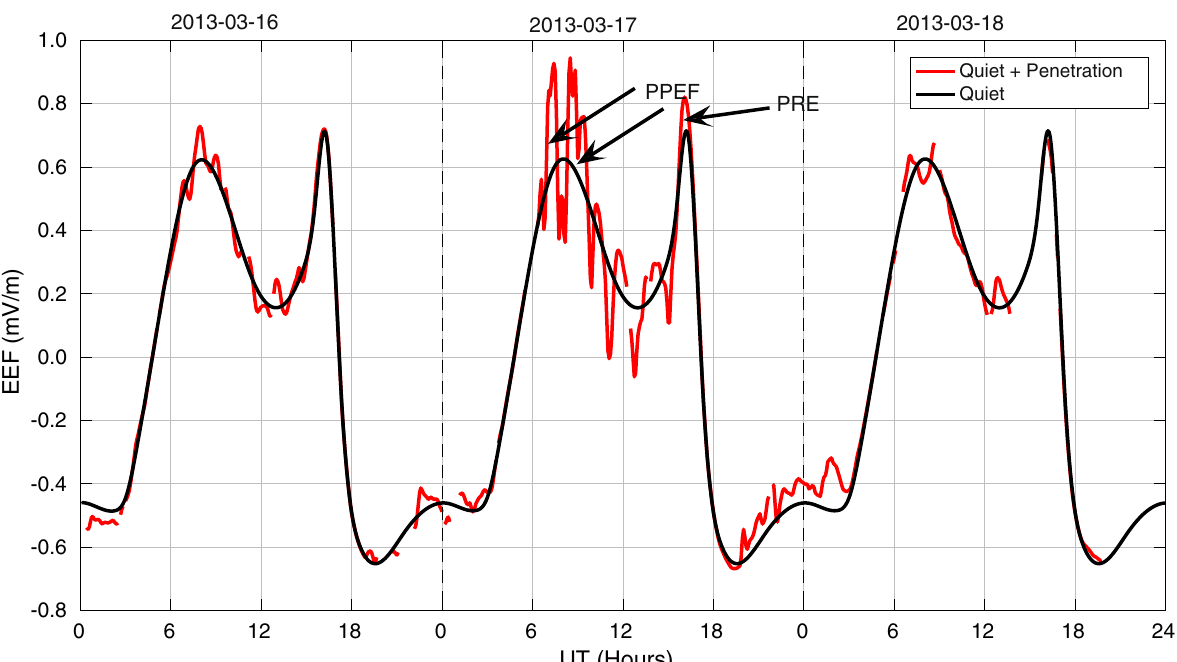
Fig. 5 Effect of penetration electric field on the quiet-time EEF during the geomagnetic storm of 16–18 March 2013